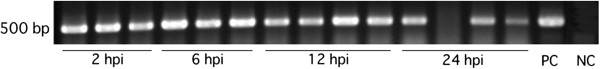
RT-PCR of infected mosquitoes. DENV-2 confirmation of infected mosquitoes at various time points shows that 13 out of 14 mosquitoes were infected, as shown by the existence of 500 bp band using RT-PCR. 2 hpi: 2 h post-infection, 6 hpi: 6 h post-infection, 12 hpi: 12 h post-infection, 24 hpi: 24 h post-infection, PC: positive control, NC: negative control.